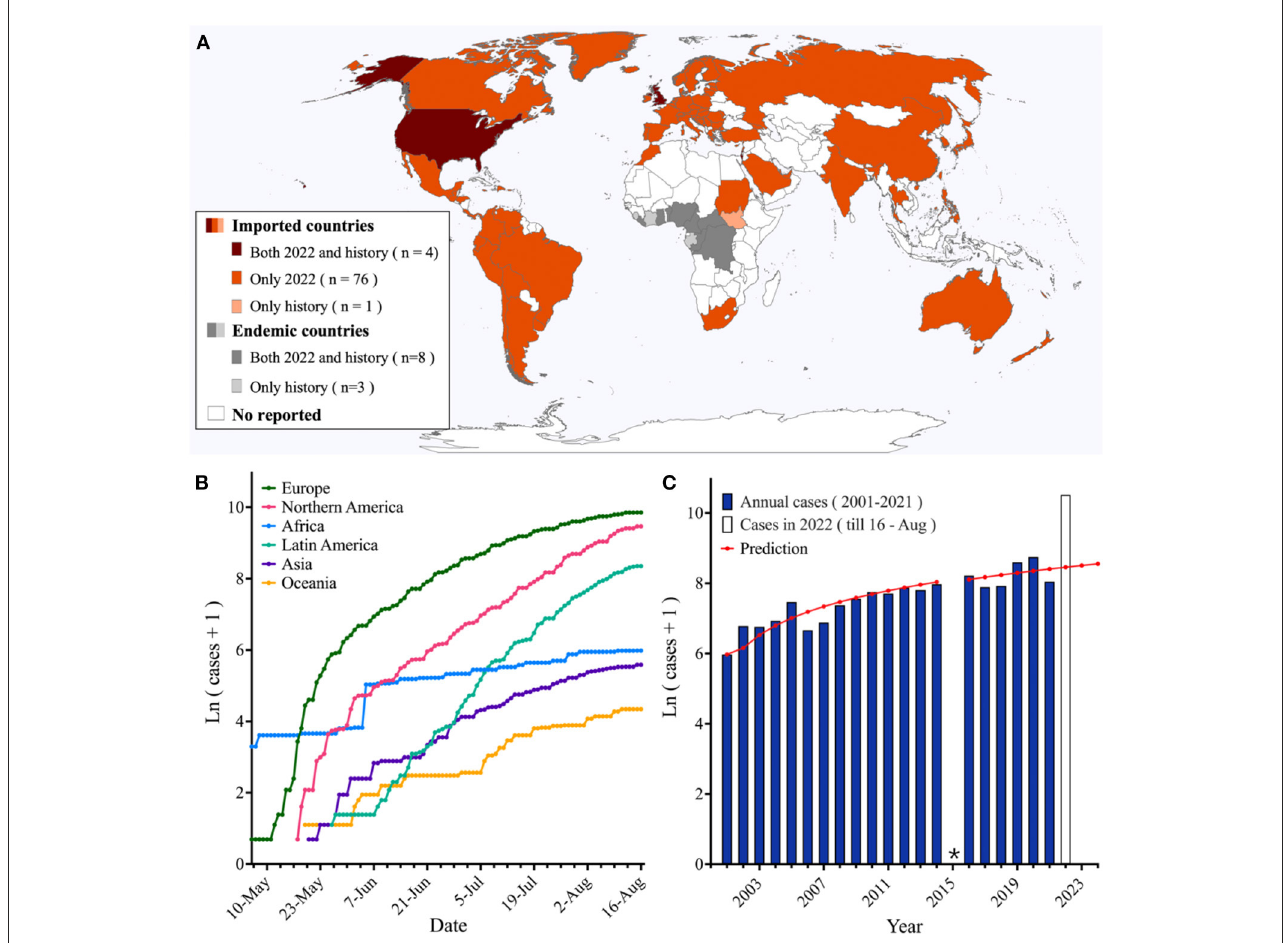
FIGURE1 Spatiotemporal distribution of MPX infections. (A) Geographic distribution of reported MPX cases from 1970 to 2022. (B) Epidemiological curves of MPX in six continents from 6 May to 16 August 2022. (C) Prediction of yearly MPX case numbers from 2001 to 2024 using the GM (1, 1). *There is no prediction for 2015 due to a lack of observation data. Data obtained from the Global Health Team 1 and the literature (23). MPX, monkeypox infections.